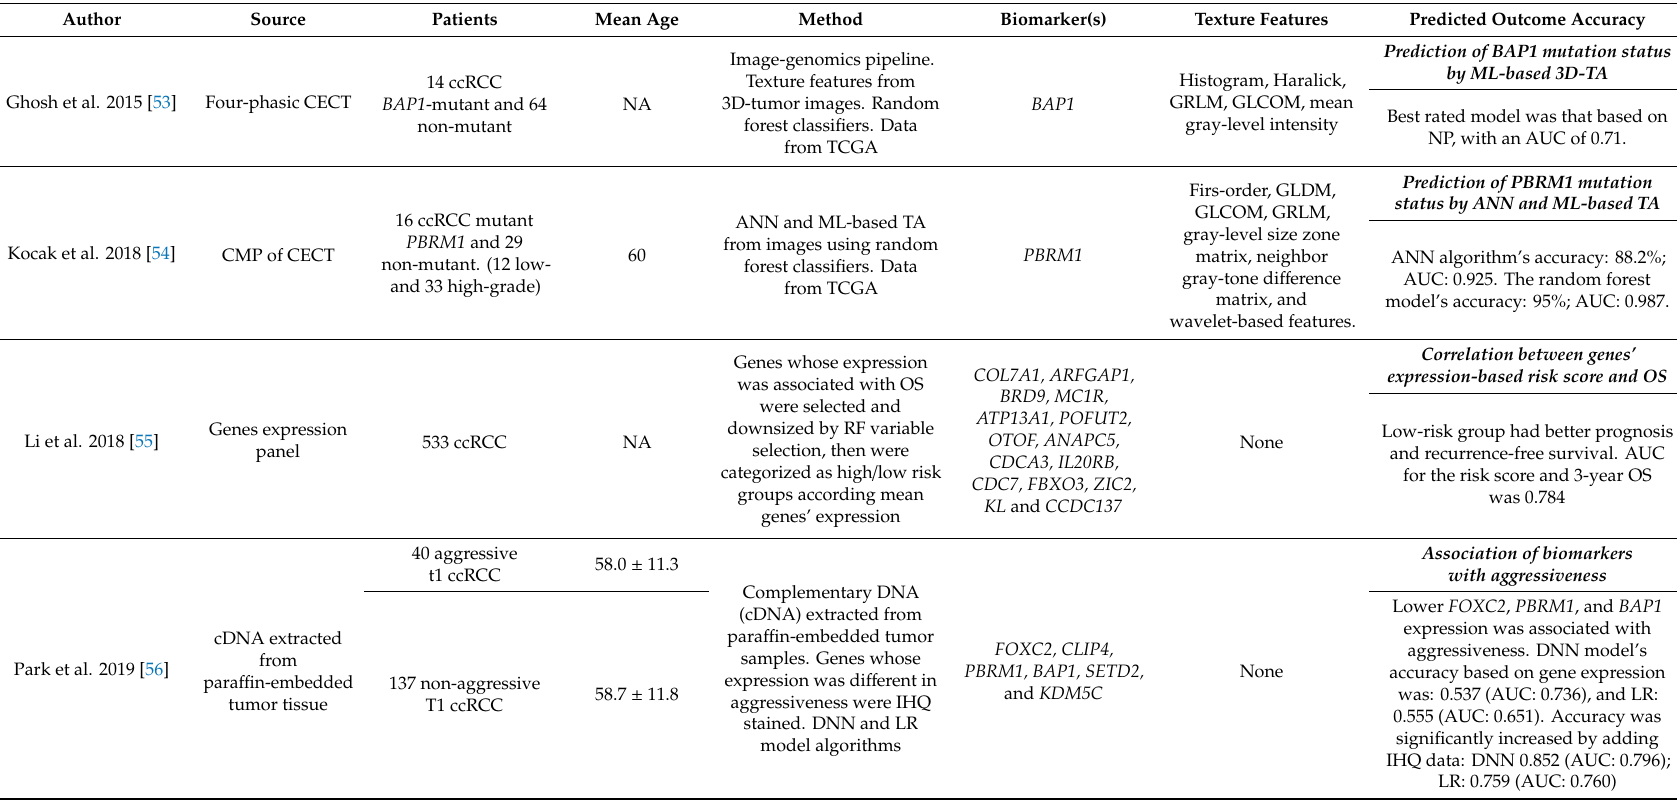
Table 3. Summary of studies applying radiomics and gene expression-based models to identify molecular